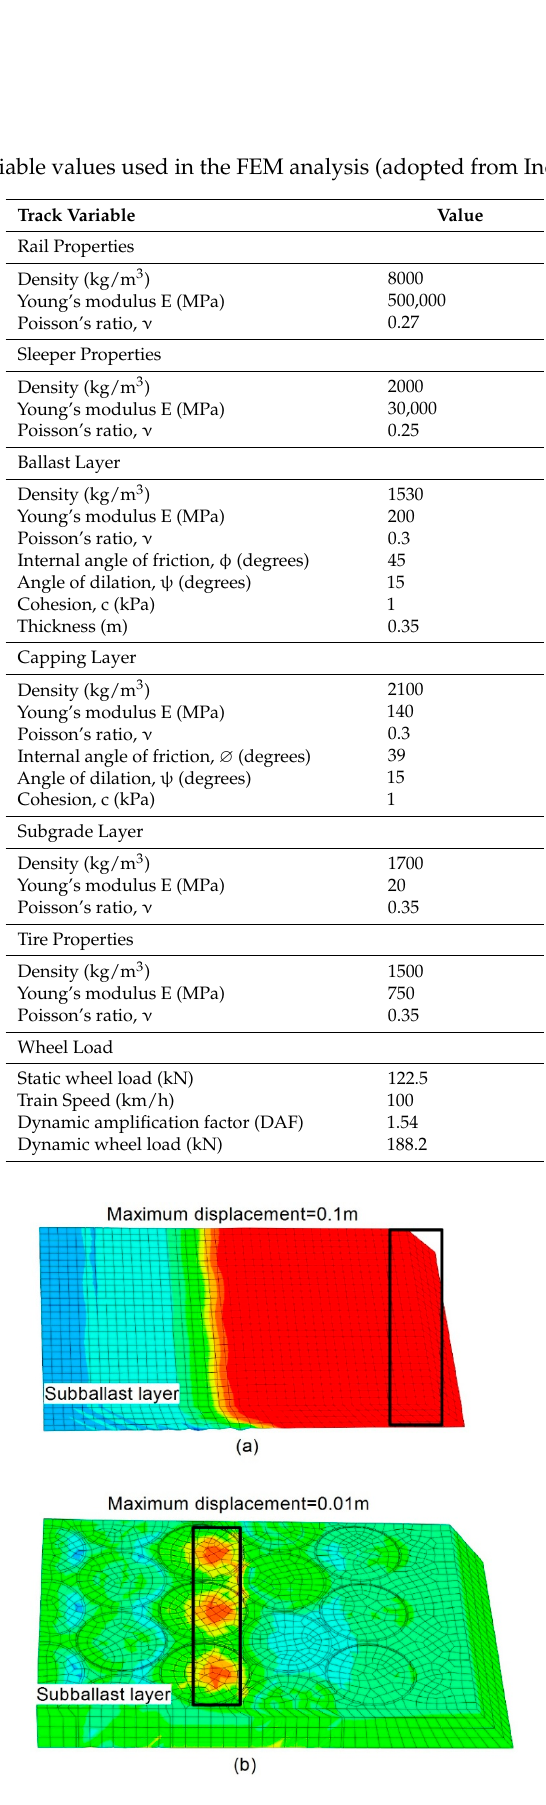
Figure 12. Lateral displacements in the sub-ballast: ( a ) without rubber tires and ( b ) with rubber tires (modified after Indraratna et al. [8]).